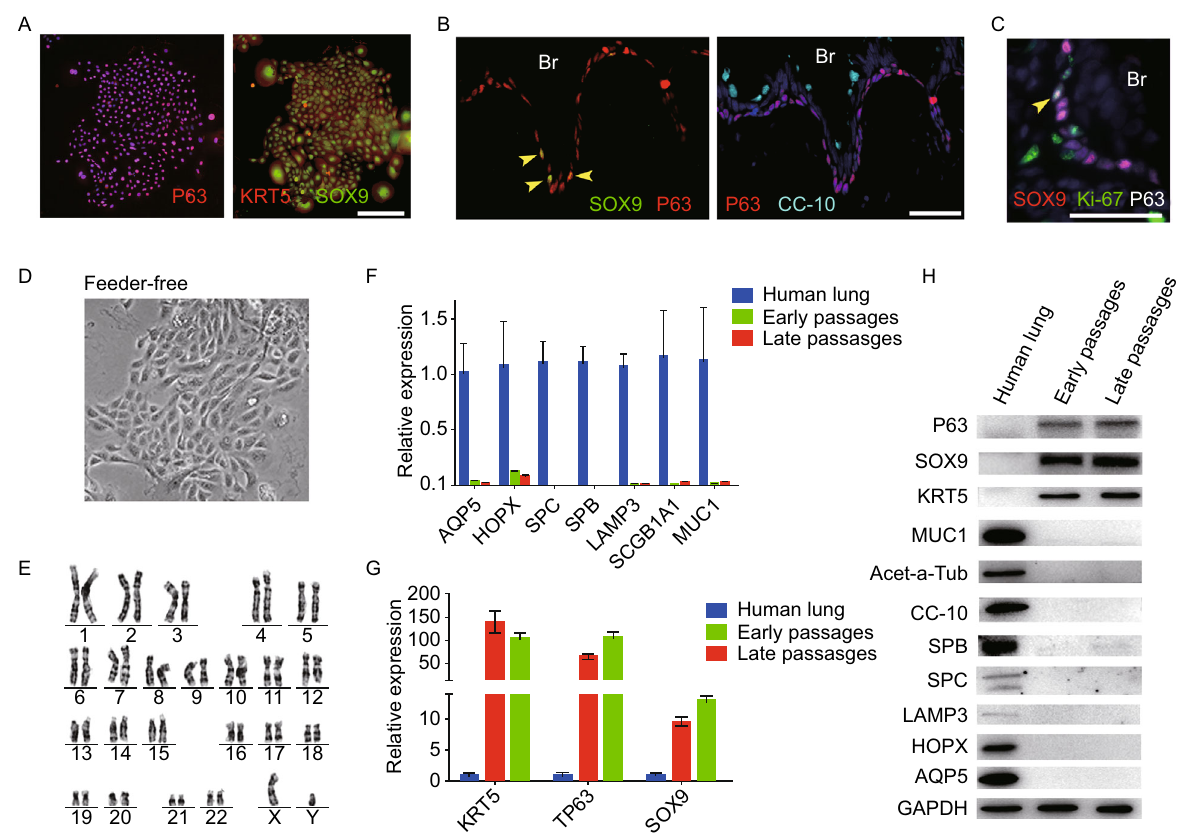
Figure 2. Feeder-free expansion of SOX9 + BCs. (A) Immunostaining of SOX9 + BCs with anti-P63, anti-KRT5 and anti-SOX9 antibodies. (B) SOX9 + BCs in rugae of 3rd order human airway by anti-SOX9, anti-P63 and anti-CC10 immunostaining. Scale bar, 100 μ m. (C) SOX9 + BCs in rugae of 3rd order human airway by anti-KI67 immunostaining. (D) BC colony cultured on feeder-free condition. (E) Karyotyping of cultured BCs. (F) qPCR showing alveolar and bronchial epithelium marker gene expression of human lung sample and SOX9 + BCs in early (P2) and late (P8) passages. n = 3, biological replicates. Error bars, S.E.M. (G) qPCR showing progenitor cell marker (Krt5, P63 and SOX9) gene expression of human lung sample and SOX9 + BCs in early (P2) and late (P8) passages. n = 3, biological replicates. Error bars, S.E.M. (H) Western blotting showing marker gene expression of human lung sample and SOX9 + BCs in early (P2) and late (P8)